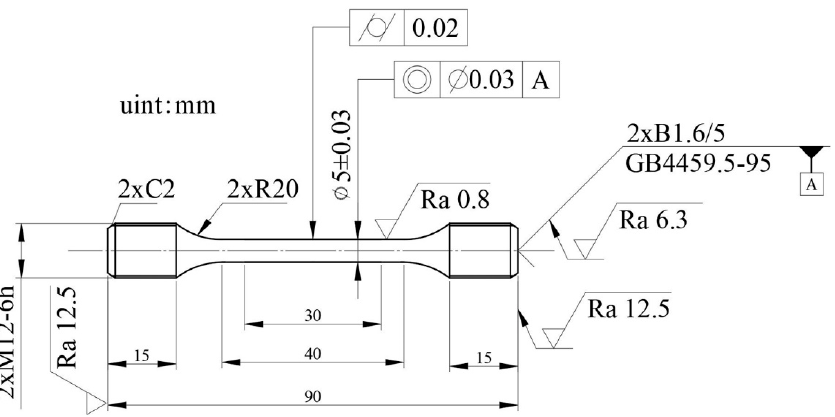
Figure 2. Geometry and size of specimens used for room-temperature tensile tests.